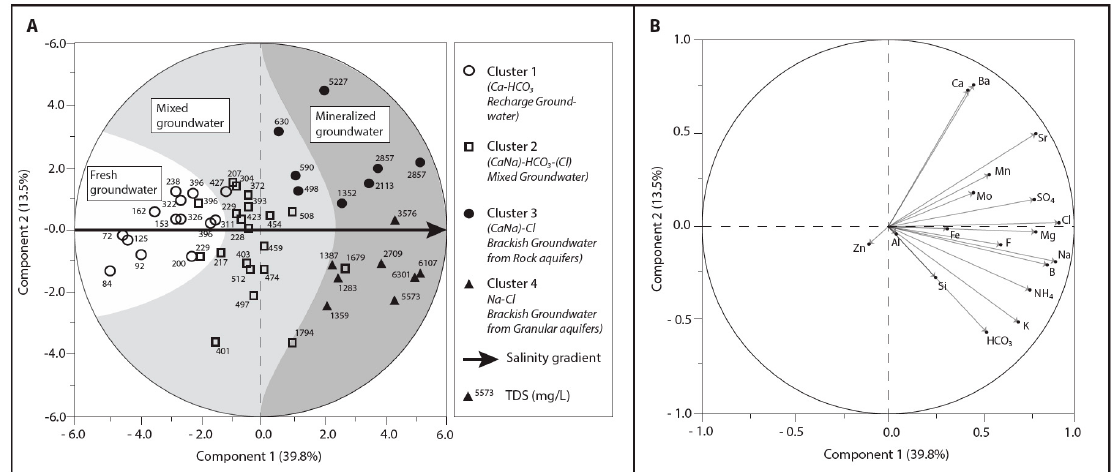
Figure 8. Graphical representation of PCA results. The horizontal axis of the correspondence circle corresponds to the first principal component (Component 1: 39.8% of the total variance of the dataset), and the vertical axis corresponds to the second principal component (Component 2: 13.5% of the total variance of the dataset). In ( A ), sample loading for Components 1 and 2 are plotted according to the Cluster to which they belonged. Chemical element loadings for Components 1 and 2 are plotted in the correspondence circle in ( B ).